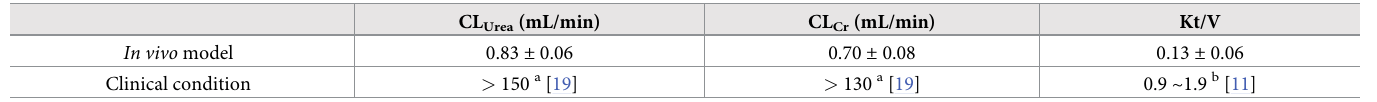
Table 2. Dialysis efficiency by HD